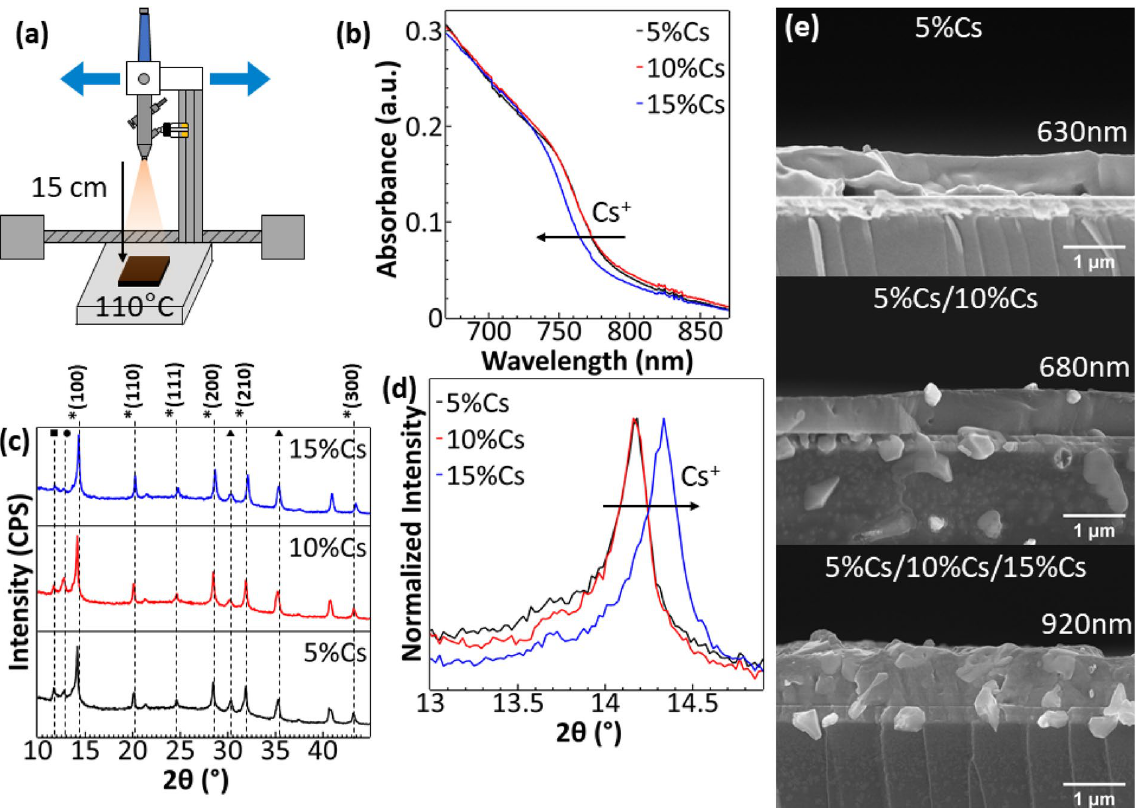
Figure 1. ( a ) Schematic of spray deposition setup used in this research. The airbrush was attached to the screw which was driven by a stepping motor, which moves the airbrush left and right on top of the hot plate. ( b ) UV–Visible spectra at the absorption edge of triple cation perovskite films with different Cs + content. ( c ) X-ray diffraction spectra (XRD) of triple cation perovskite (labeled with *) films with different Cs + contents. PbI 2 peaks were labeled with •. Optically inactive FAPbI 3 peaks were labeled with ▪ . ITO substrate peaks were labeled with ▴ 39,45,46 . ( d ) XRD spectra of triple cation perovskite films at the 2θ from 13° to 15°. ( e ) SEM cross-sections of single (5%Cs), double (5%Cs/10%Cs), and triple-layer (5%Cs/10%Cs/15%Cs) perovskite increases. The reduction of FAPbI 3 with higher Cs + content is the result of smaller Cs/FA/MA cation effective radius, which shifts the tolerant factor toward cubic lattice rather than the hexagonal phase of FAPbI 3 39,48 . A very small peak at 12.79° corresponds to PbI 2 crystal, pointing to incomplete formation of perovskite. The additional 2.5% of cation salt by weight is necessary to reduce the PbI 2 in perovskite crystal. Without the additional cation, PbI 2 in perovskite crystal was more significant. However, too much additional cation can also affect the perfor- mance. As shown in Fig. S4, the increase of cation reduces the performance of PPDs with 2.5% cation being the best performance with the lowest PbI 2 peak. To determine the effectiveness of SSD for depositing multilayer perovskite films without layer dissolution, cross-section images were captured as shown in Fig. 1e. The dissolution of the perovskite layer can occur both when depositing the same layer for multiple times and when depositing a new layer on top of the finished layer.